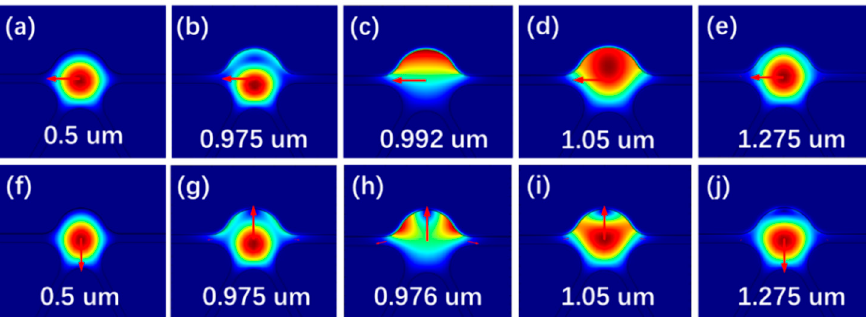
Figure 3. Electric field distributions of core modes of ( a – e ) X-polarization at analyte RI n a = 1.33 ( f – j ) Y-polarization at analyte RI n a = 1.33.